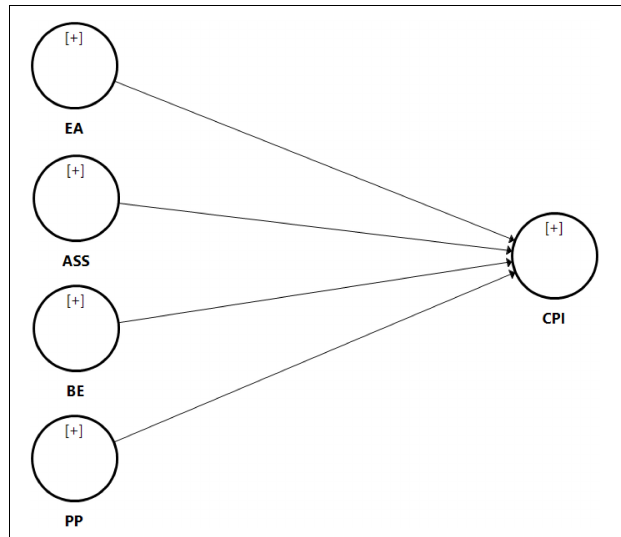
FIGURE 1 | Results of assessment of structural model. ASS, after sales service; BE, brand equity; CPI, consumer purchase intention; EA, environmental awareness; PP, product pricing.